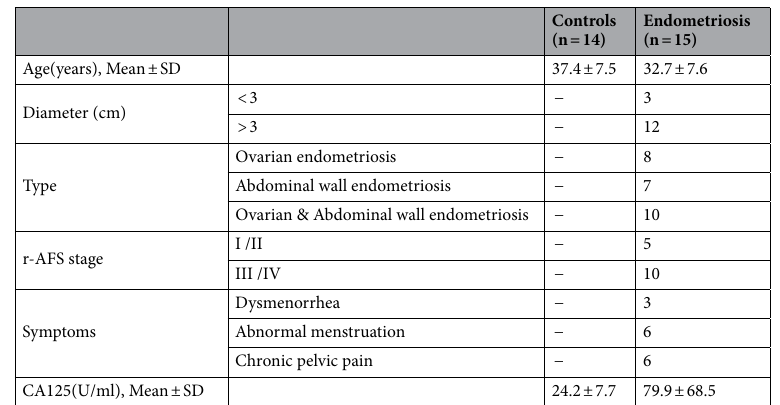
Table 2. Clinical characteristics of samples included in the study. r-AFS revised American Fertility